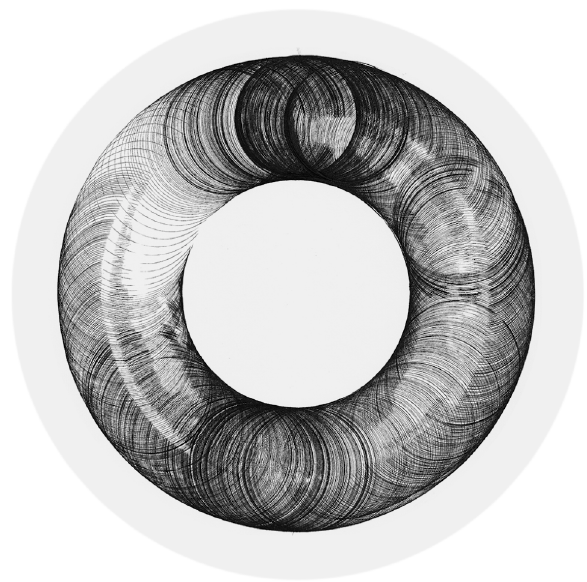
Figure 6 | Mixer Drawing Nr. 2. Parallel circles.